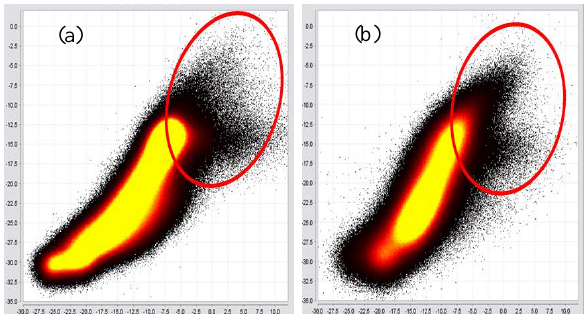
Figure 2. Relation between HH σ0 (x-axis) and HV σ0 (y-axis) showing built-up class encircled in ‘red’ over (a) Kolkata- Haldia site and (b) Munger-Jamalpur twin city